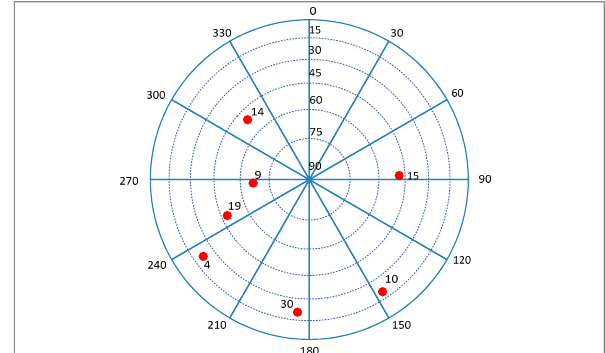
Figure 21. Sky plot of the satellites in Trajectory 2.